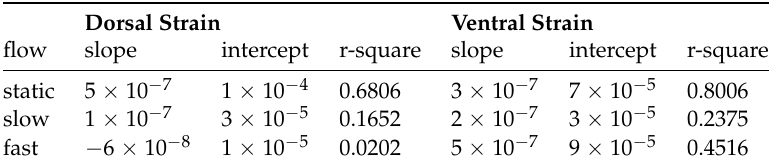
Figure 12. Time series bi-variate plots of dorsal and ventral strains over duration of tests for respective flows: static ( a ), slow ( b ), fast ( c ). Table 4. Time-based minimum least squares regressions of final 250 s of strain measured on dorsal and ventral gages of the rostrum during horizontal placement in three flows (removing the first 50 s of the full